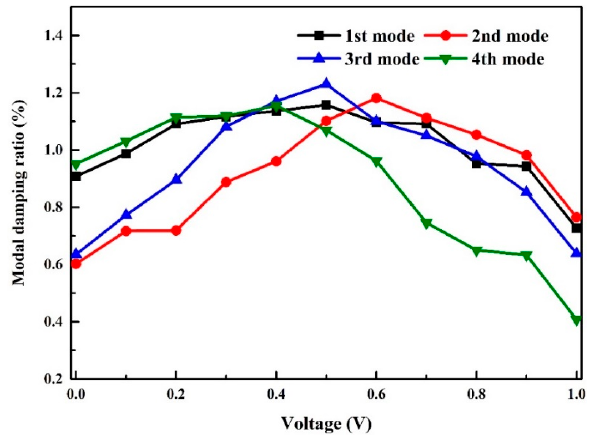
Appl. Sci. 2017 , 8 , 118